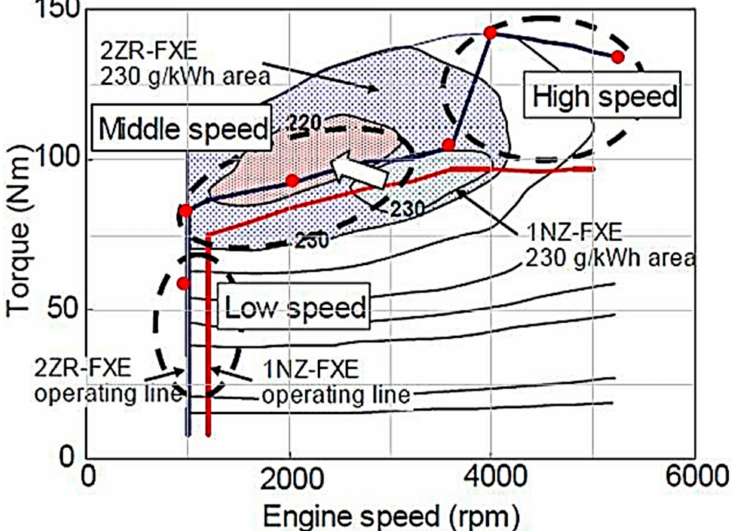
Figure 10. Brake Specific Fuel Consumption (BSFC) Map of the 2ZR-FXE Engine.